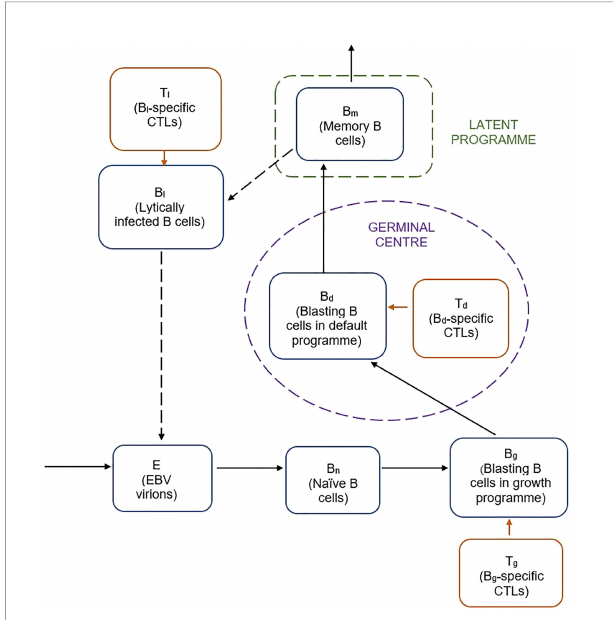
FIGURE 1 | Schematic of previously reported mathematical model of EBV viral kinetics